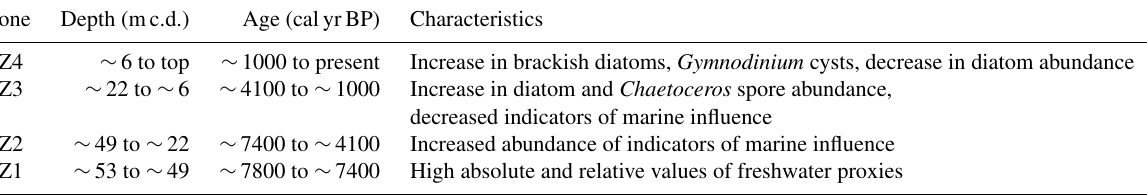
Table 2. Environmental zones of the Holocene record at Site M0059. Zone Depth (mc.d.) Age (calyrBP) Characteristics